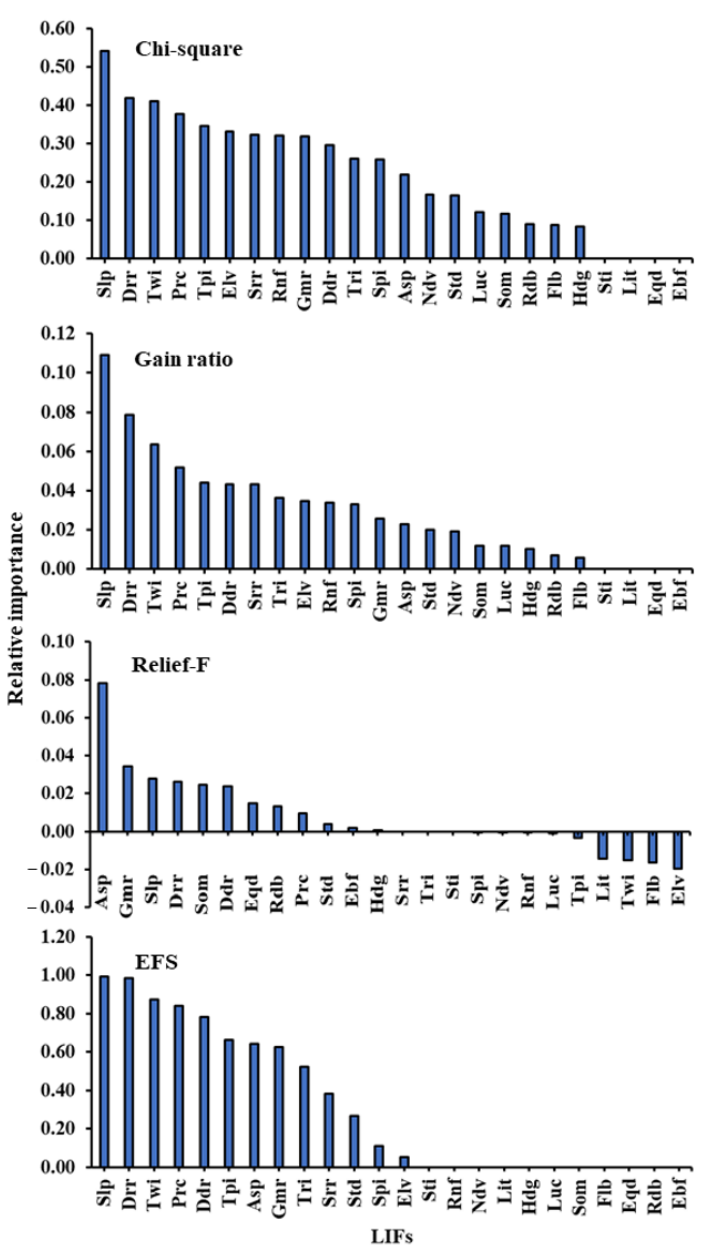
Figure 7. The relative importance of different LIFs derived from individual FS and EFS methods. LIFs are sorted in descending order based on their relative importance. The abbreviations of the LIFs are defined in Table 3.